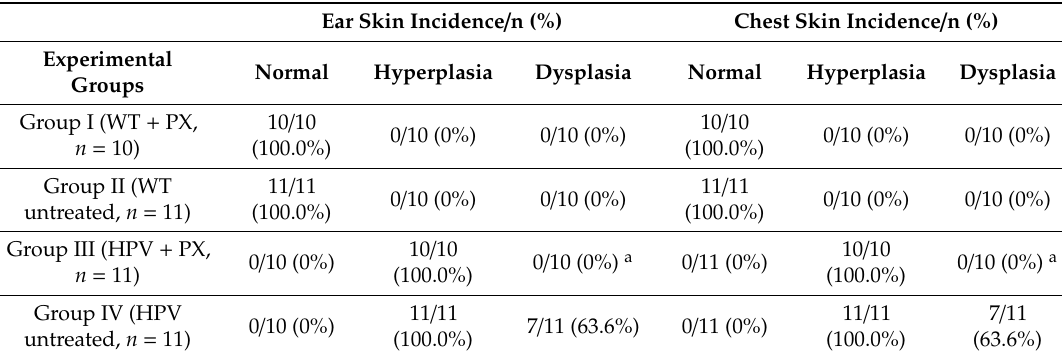
a Statistically different from group IV ( p = 0.027). HPV—human papillomavirus; PX—parecoxib; WT— wild ‐ type.